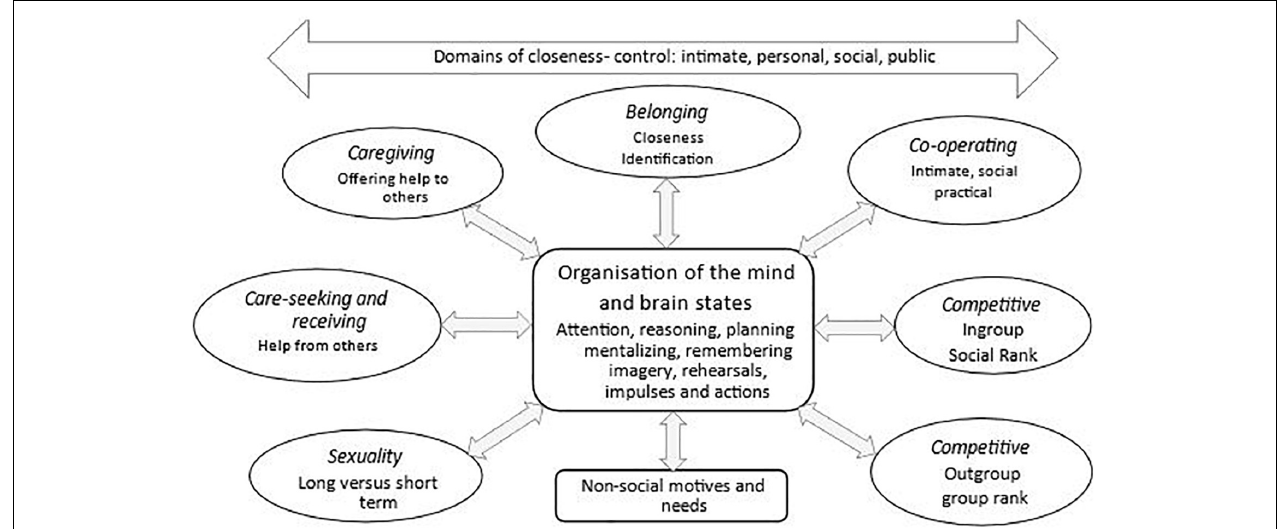
FIGURE 1 | The organizing functions of motives and social mentalities. ©Paul